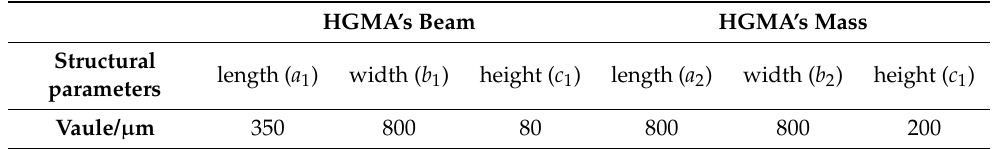
Table 1. The specific values of HGMA’s structural parameters.